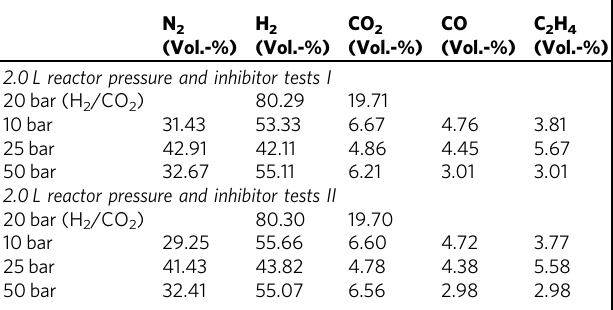
Table 4 Gas composition of experiments performed in the 2.0 L